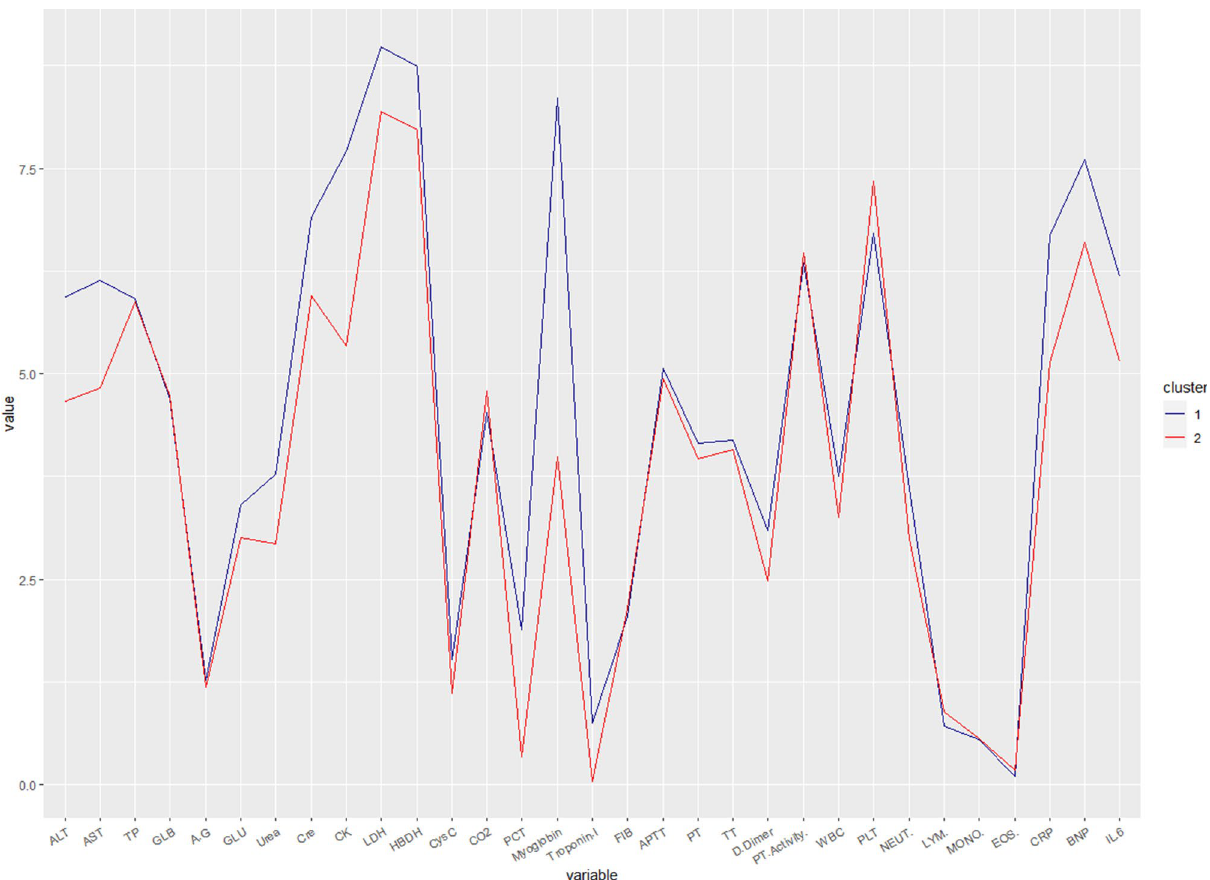
Figure 6. Cluster analysis of significant clinical parameters in deceased and recovered patients. Blue line (1) indicates dead while red (2) indicates recovered